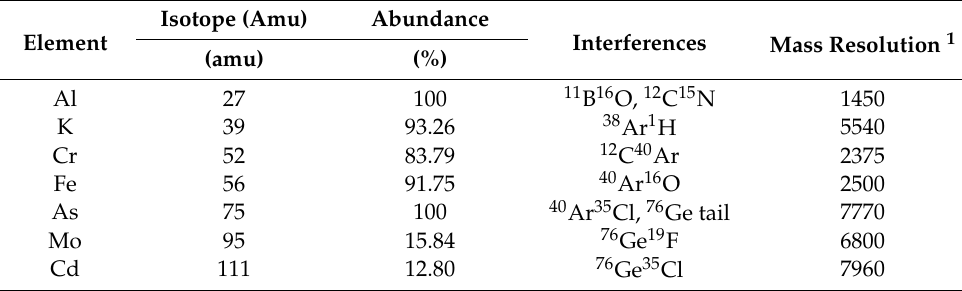
Table 7. Interferences observed during